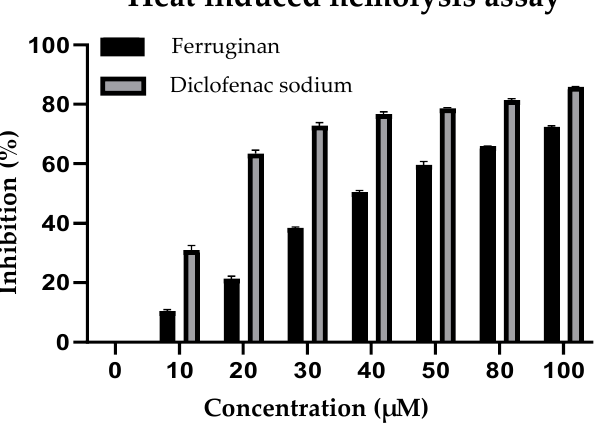
Figure 2. Effect of ferruginan, in comparison with diclofenac sodium (standard), in the heat-induced hemolysis assay. Experiments were performed in triplicate, and values are reported as mean ± SD.